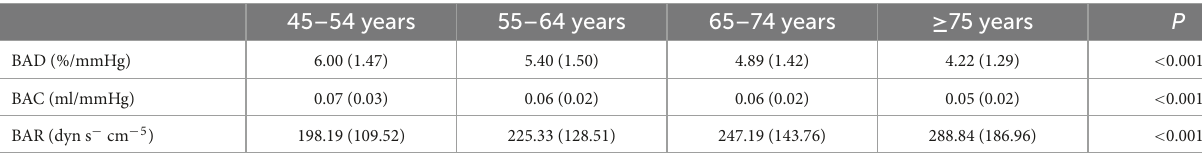
TABLE 2 Comparison of arterial elasticity components in different age groups.